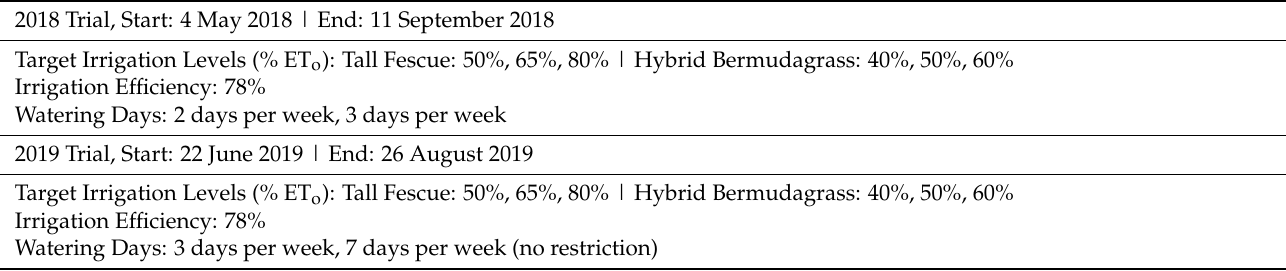
Table 1. Irrigation treatments throughout the 2-year tall fescue and hybrid bermudagrass irrigation research experiments at the University of California Kearney Research and Extension Center.